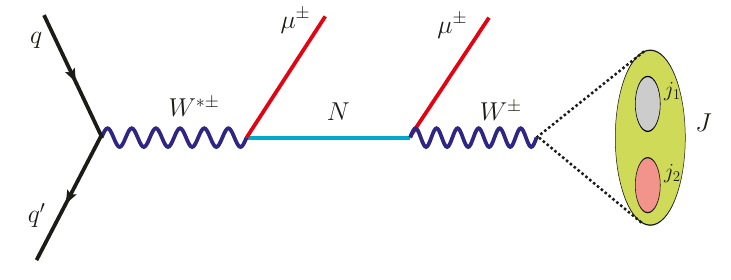
Figure 1 . SSDL + fat-jet production at the